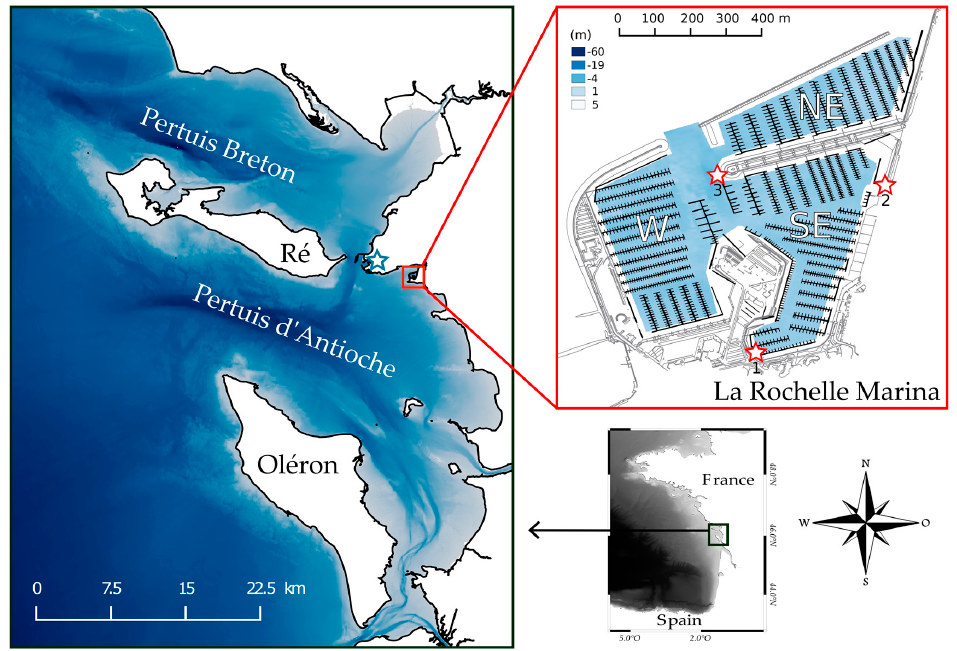
Figure 1. Bathymetry / topography map of the modelling domain (left) and the La Rochelle marina (right). Depths are given with respect to mean-sea-level, and the straight, bold black line indicates the shoreline in the left figure while La Pallice weather station is symbolised by a blue-bordered white star. At right, the floating docks are signified by a black line, and the maritime infrastructures are indicated by a grey line. The red-bordered white stars numbered 1, 2, and 3, represent the location of the rainwater outlet, the fairing area, and the fuel station, respectively. Western, southeastern and northeastern basins are denoted by white characters W, SE and NE, respectively.